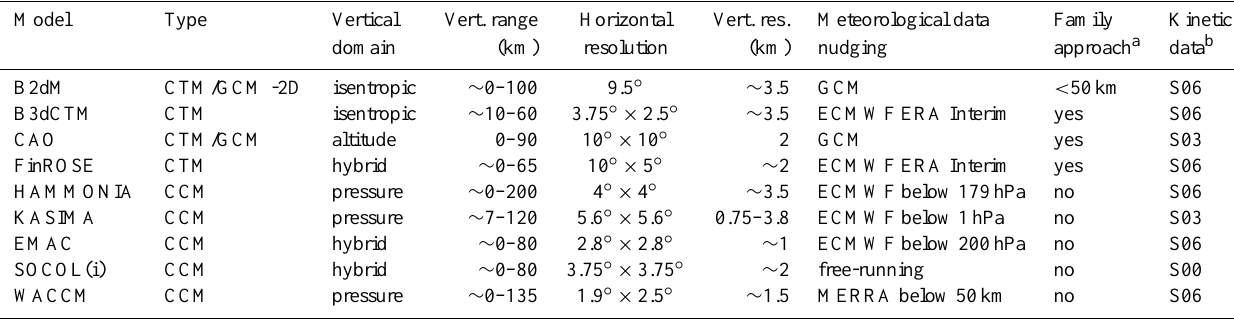
Table 3. Summarized description of the models involved in this study.